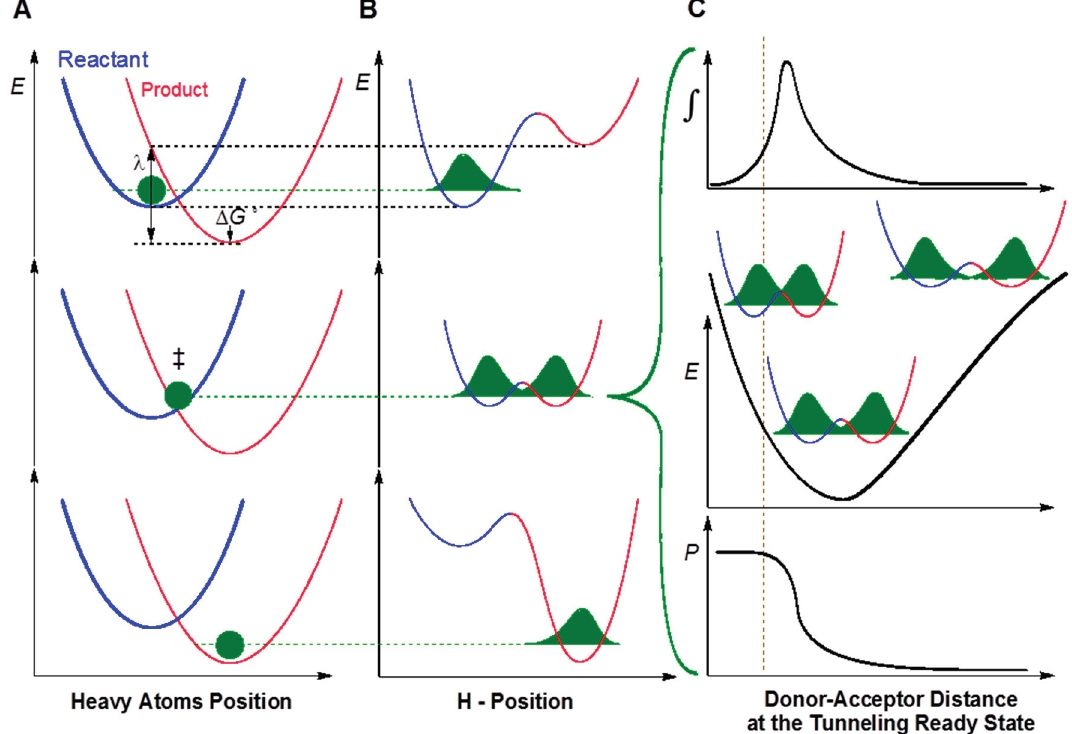
Figure 3. An example of a model used to analyze kinetic isotope effects (KIE) for H-transfer reactions (sometimes called Marcus-like models). Three slices of the potential energy surface (PES) along components of the collective reaction coordinate showing the effect of heavy-atom motions on the zero point energy in the reactant (blue) and product (red) potential well. ( A ) Presents the heavy atom coordinate (also known as the Marcus parabolas); and ( B ) shows the H-atom position, which is orthogonal to the heavy-atom coordinate. In the top panels, the hydrogen is localized in the reactant well, and the zero point energy of the product state is higher than that of the reactant state. Heavy atom reorganization brings the system to the tunneling ready state (TRS, middle panels A and B ), where the zero point energy in the reactant and product wells are degenerate and the hydrogen can tunnel between the wells. Further heavy atom reorganization breaks the transient degeneracy and traps the hydrogen in the product state (bottom panels). The rate of reaching the TRS depends on the reorganization energy ( λ ) and driving force ( Δ G °), which are indicated in the top panel (see [24] for more details and equations); ( C ) shows the effect of Donor–Acceptor Distance (DAD) sampling on the wave function overlap at the TRS (middle panel). Transmission probability ( P ) is a function of the overlap integral of the hydrogen wave functions in the reactant (blue) and product (red) wells (bottom panel C ). The top panel C presents the contribution to H-transfer at each DAD as a function of the P and the population at each DAD. The vertical dashed line represents the DAD under which the Zero Point Energy (ZPE) is greater than the barrier height. At such distances, the process of a wave function spreading from reactant well to product well is no longer “tunneling”, but one can still use the particle’s transmission probability analogously to the tunneling probability at longer